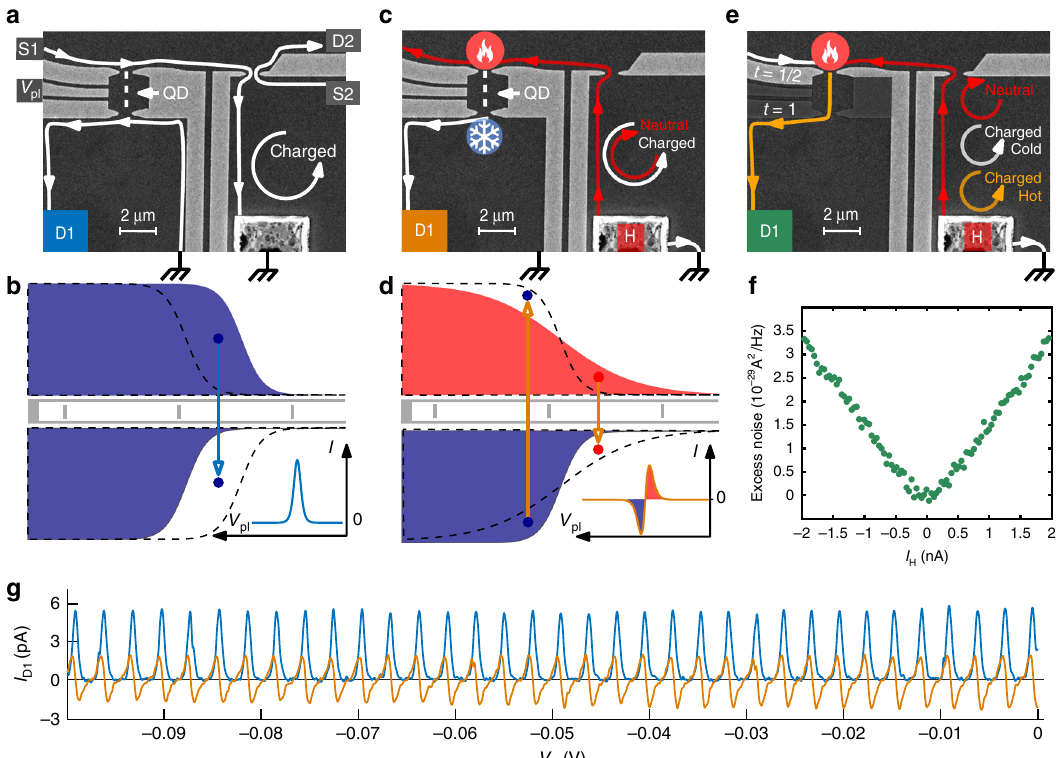
Fig. 1 Description of the experimental device and methods. a Scanning electron microscope (SEM) image of the device. In this con fi guration, the current is sourced from S1, reaching to the quantum dot (QD). Sweeping the plunger gate voltage results in a succession of Coulomb peaks as shown by the blue curve on g . b Schematic of the equilibrium distribution on each side of the QD. When the plunger gate is tuned, electron can tunnel into the dot from the high occupation number region to the lower one, creating a positive current measured at D1. c Neutral mode heat detection con fi guration: The current sourced in H is directed to the ground and plays no part in the experiment. A hot spot present at the upstream side of contact H excites the neutral heat modes fl owing upstream toward the QD, creating a thermal gradient across the QD. The produced thermoelectric current then fl ows to D1. d Sketch of the equilibrium distribution on both side of the dot in the case depicted in c . In this case, the tunneling direction will depend if an energy level of the QD is placed below or above the center of the distribution. This induces an alternating current when the plunger gate is tuned. e Noise measurement con fi guration: Here the input QPC of the QD is set to half transmission while the second one is fully open. This turns the QD into an effective single QPC device. The heat carried by the neutral modes increase the electron temperature at the input QPC of the dot, which increases the Johnson – Nyquist noise, measured at D1. f Excess noise measured at D1 as function of current injected in H, as described in e . g Measurement corresponding to the con fi guration a in blue and c in